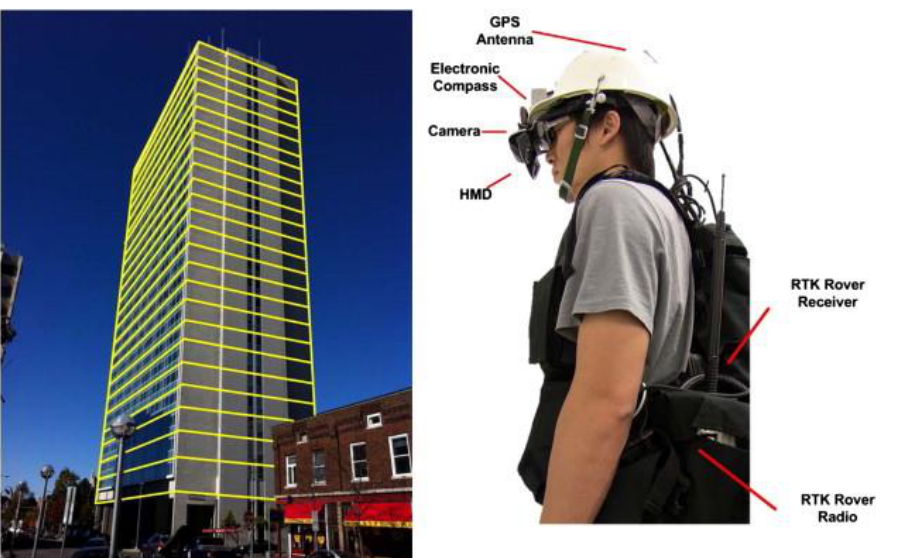
Figure 16. Schematic overview of the introduced AR-assisted assessment framework to estimate the IDR [105].